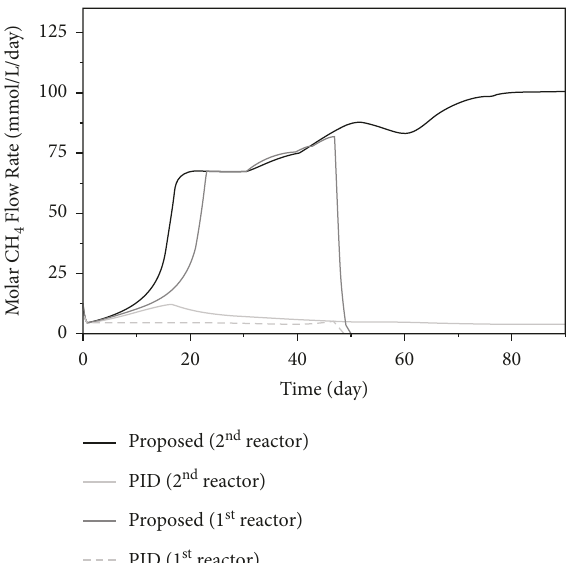
Figure 8: The responses of methane production rate under the condition with inlet COD concentration